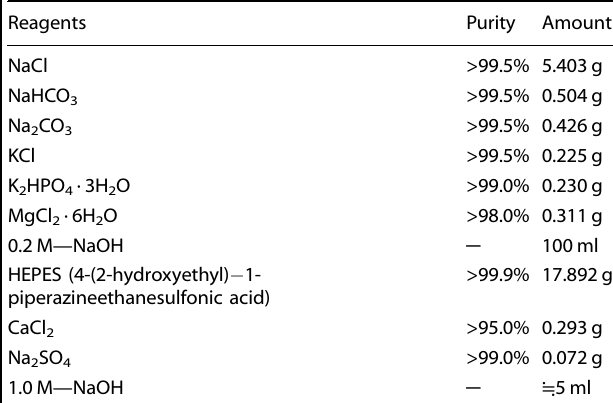
Table 4. Reagents, purities and amounts for preparing 1000 ml of m-SBF 62